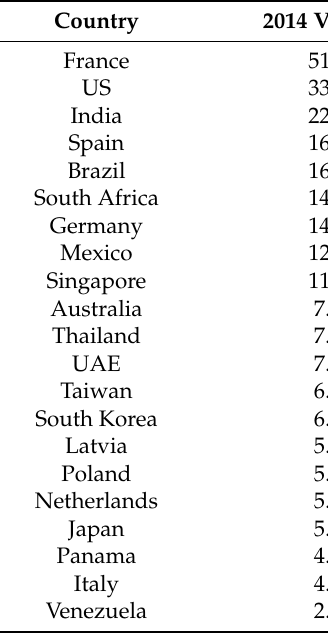
Table 1. Snapshot of leading export markets for Scotch